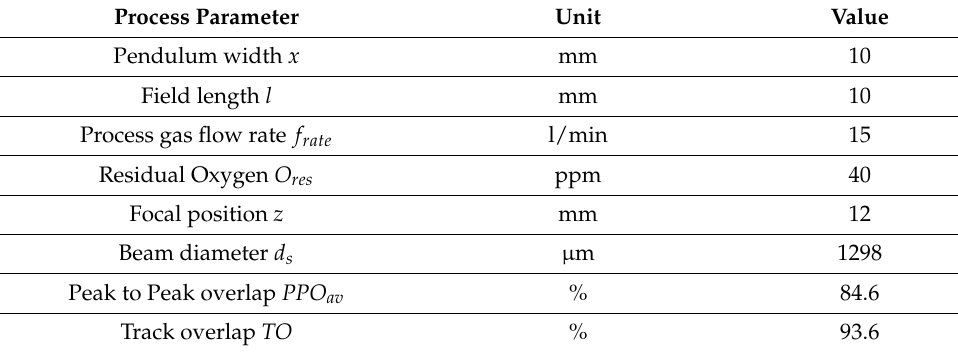
Table 4. Constant process